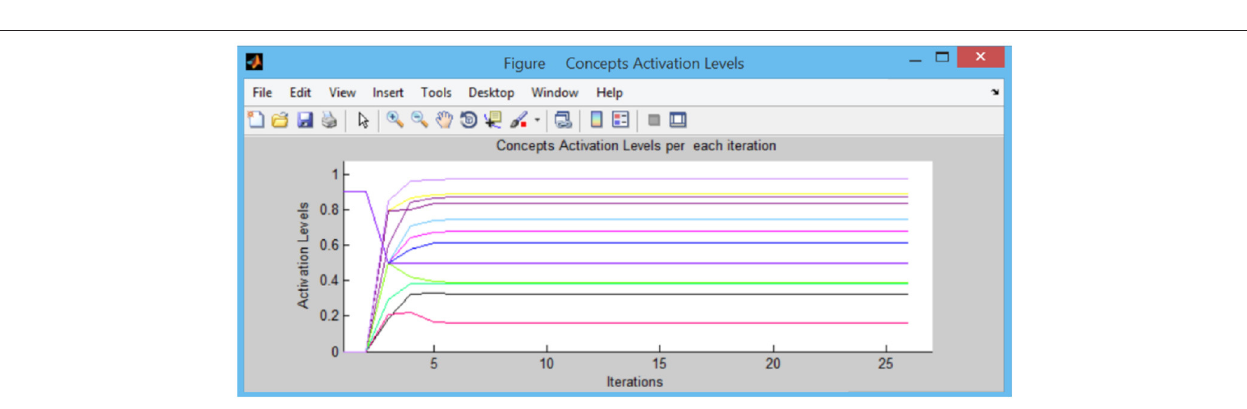
FIGURE 10 | Concept activation curves per each iteration for the best case scenario of the